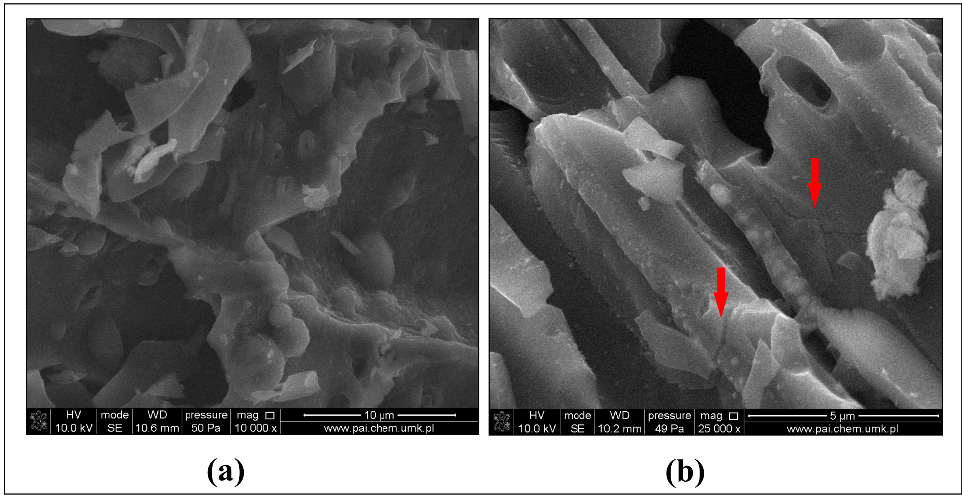
Figure 4. Scanning electron micrographs showing biochar before ( a ) and after ( b ) exposure to successive freeze-thaw cycles over 64 d. Red arrows indicate ‘cracks’ and ‘blunting’ of particle edges following freeze–thaw.